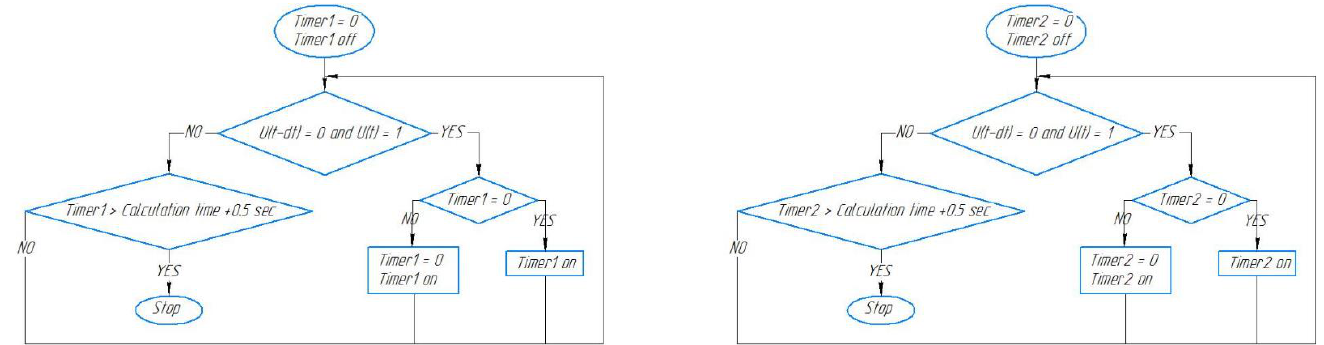
Figure 5. Block diagram of the algorithm for determining the skew of the wing mechanization section over time.